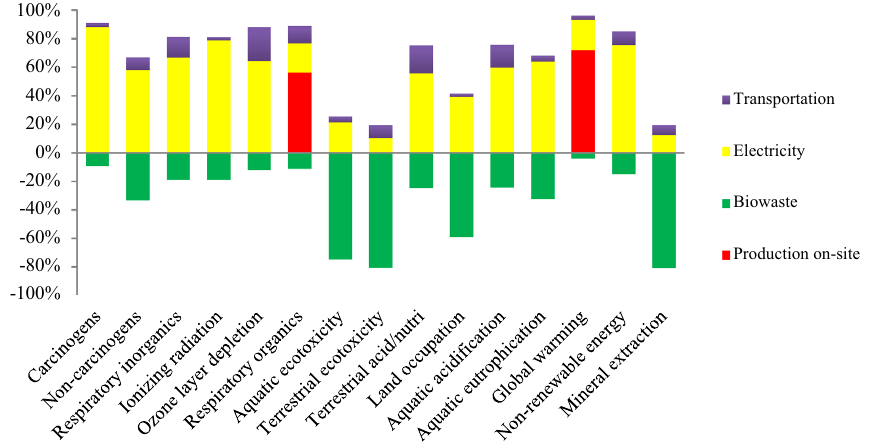
Figure 1. Relative contribution to the environmental impact of Protaetia brevitars seulensis .